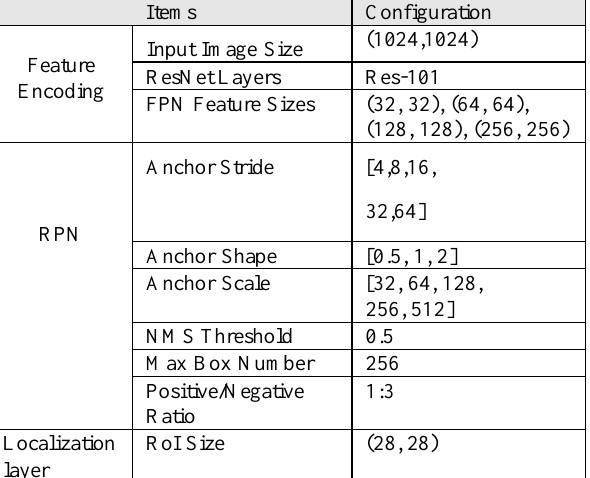
Table 5.2: Configuration of Backbone Network